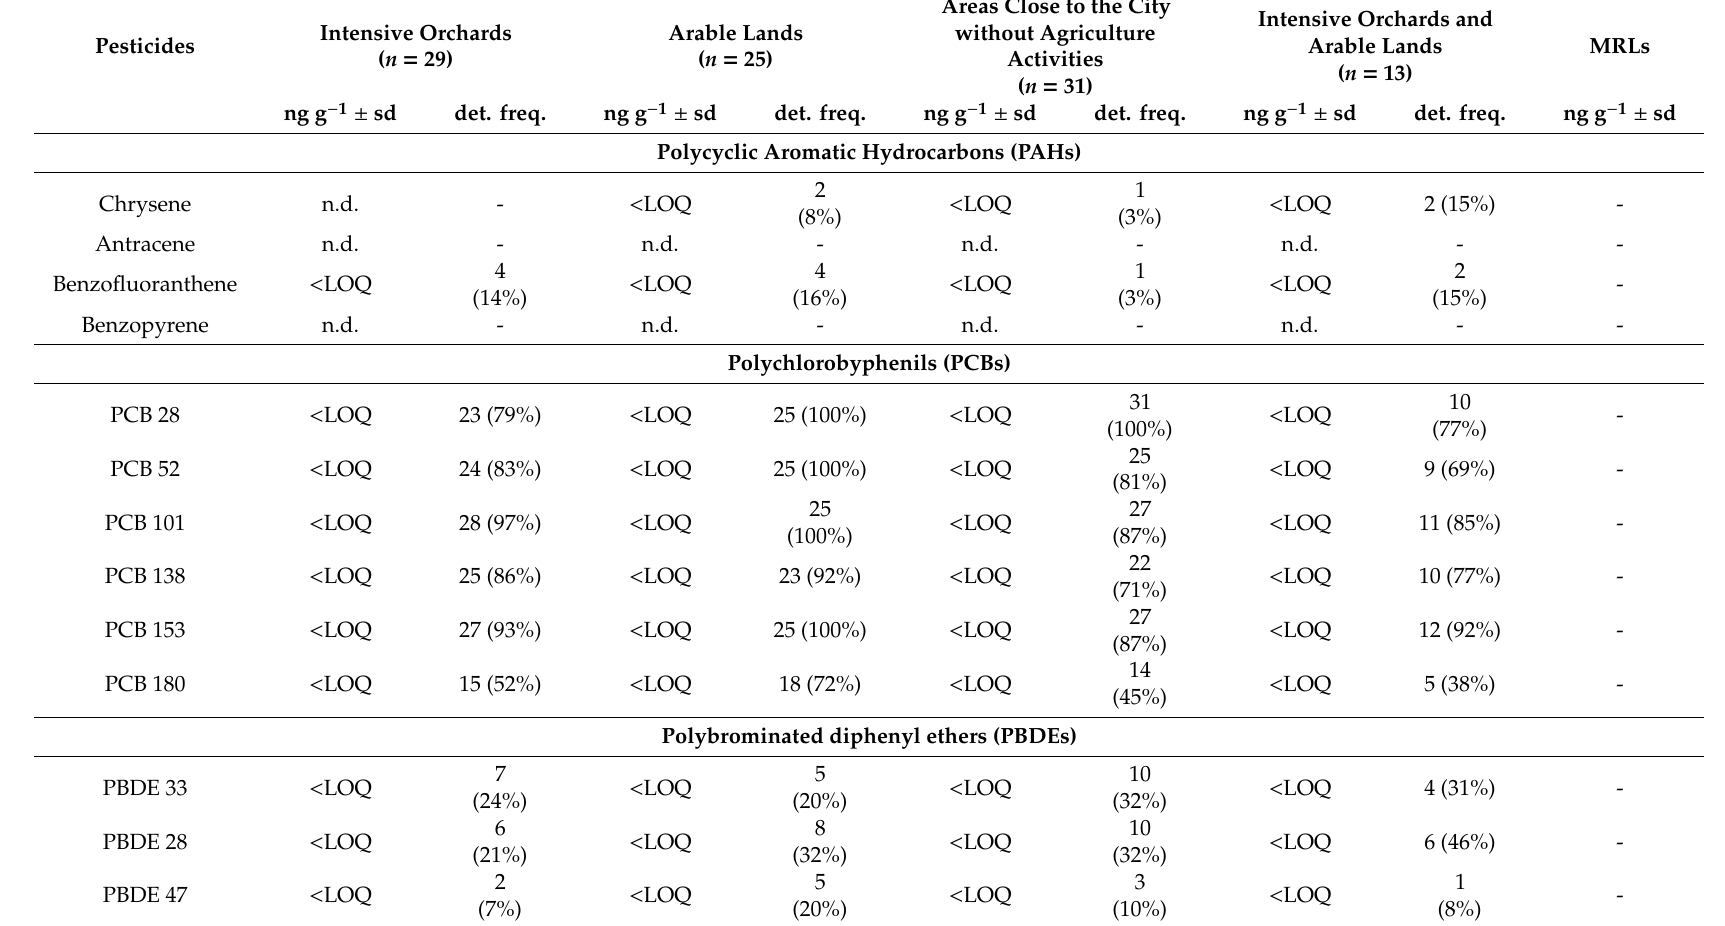
Table 2. Pesticide residues in 98 honey samples from di ff erent geographical areas of the Apulia region (Italy).